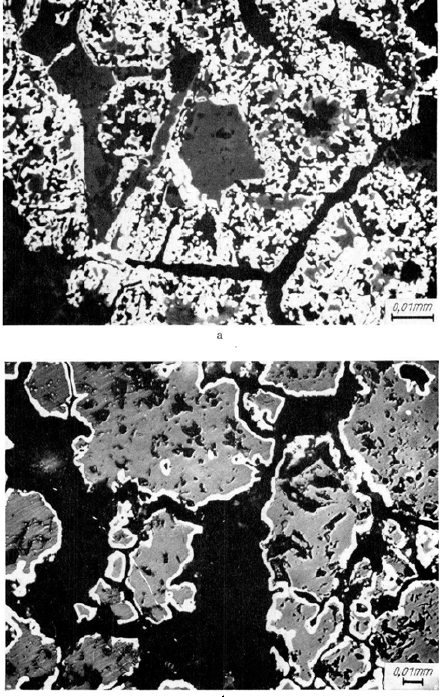
Figure 10. The SEM images of ( a ) reduced hematite; ( b ) reduced magnetite [43].